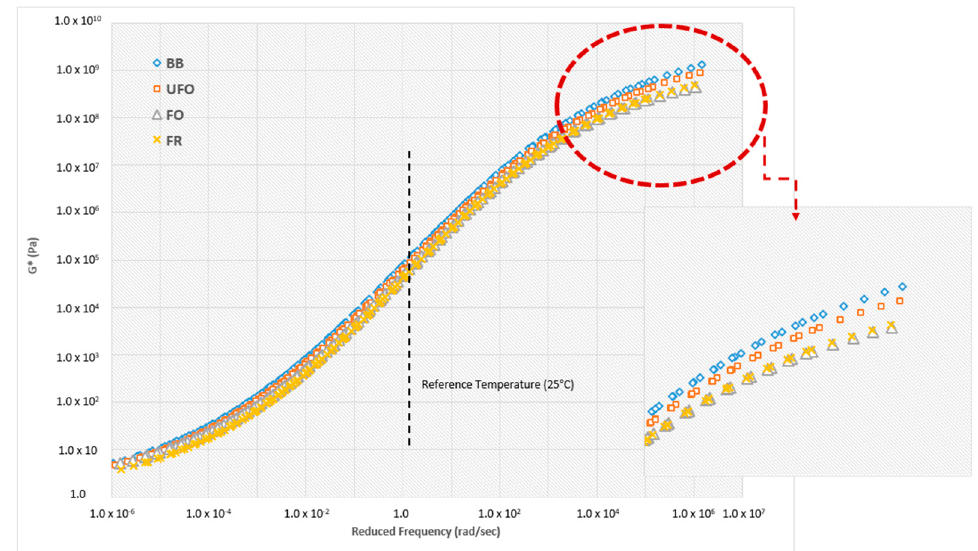
Figure 15. Comparison of master curves for unaged samples.